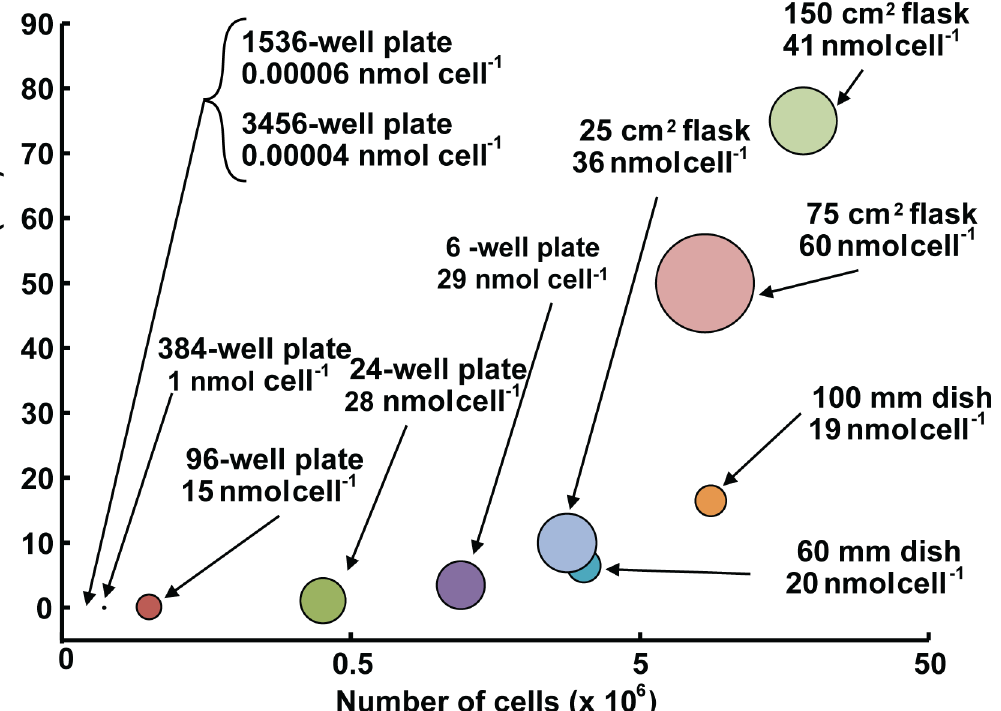
Fig 9. Exposure to xenobiotics when specified as mol cell -1 varies greatly when using different experimental platforms for cell culture. Hypothetical cell culture experiments are shown where general recommendations, such as from Invitrogen (Life Technologies, Grand Island, NY), are followed for: seeding density, estimated number of cells at confluence, and media volume when using different cell culture vessels. In all hypothetical experiments, cells were exposed to an initial concentration of 10 μ M xenobiotic in the medium. However, this leads to a wide range of doses when converted to mol cell -1 . The size of each data point (circle) is proportional to the dose in units of nmol cell -1 ; the larger the area of the circle, the higher the exposure. Note that for platforms commonly used in wet bioscience laboratories, dose per cell varies over a range of 60-fold; if platforms used for high-throughput-screening are included (1536- and 3456-well plates) then dose per cell varies over a 10 6 -fold range, despite the initial molar concentration of xenobiotic being the same for each experimental platform.